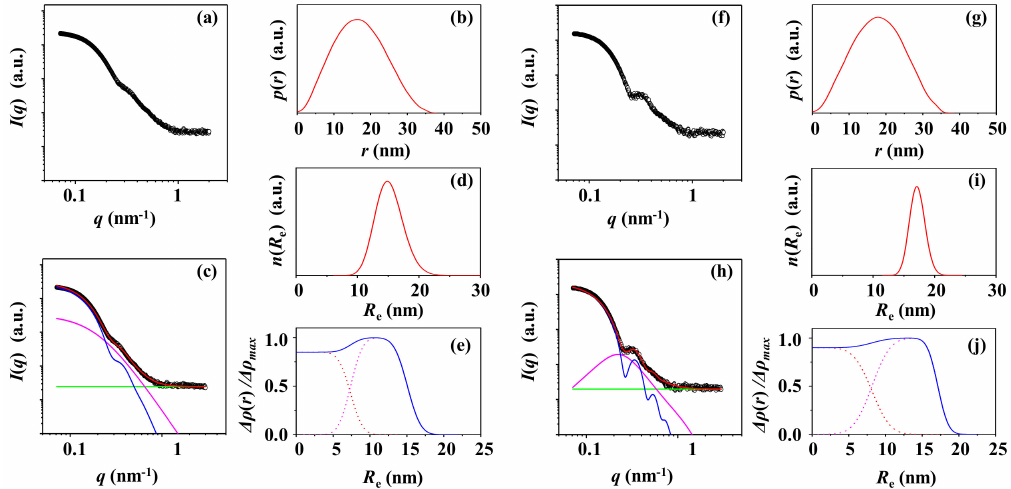
Figure 5. X-ray scattering data analysis of PS-3 particle. ( a ) SAXS profile measured at room temperature and corrected for water as the solution medium: ( b ) pair distance distribution functions p ( r ) obtained from the scattering profile using the IFT method; ( c ) data analysis results; ( d ) radius distribution obtained by the data analysis in ( c ); ( e ) density distribution obtained by the data analysis in ( c ). ( f ) SAXS profile measured at room temperature and corrected for the supernatant as a solution medium: ( g ) pair distance distribution functions p ( r ) obtained from the scattering profile using the IFT method; ( h ) data analysis results; ( i ) radius distribution obtained by the data analysis in ( h ); ( j ) density distribution obtained by the data analysis in ( h ). ( c , h ) the open symbols are the measured data and the red solid line represents the sum of the profiles obtained by fitting the data using two-phase ellipsoid model (blue line) and local random two-phase contributions (purple line) and the background (green